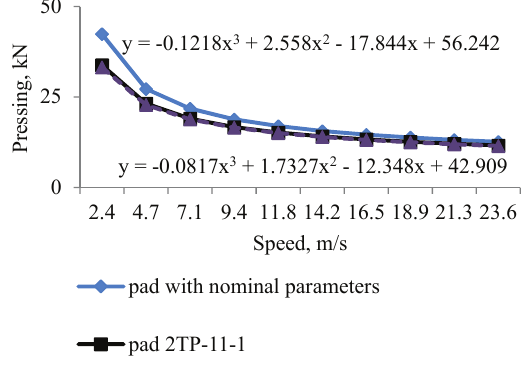
Fig. 3. Dependence of the amount of pressure on the composite pad on the speed of movement